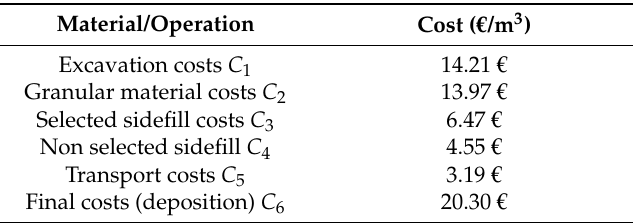
Table 4. Costs associated with the trench